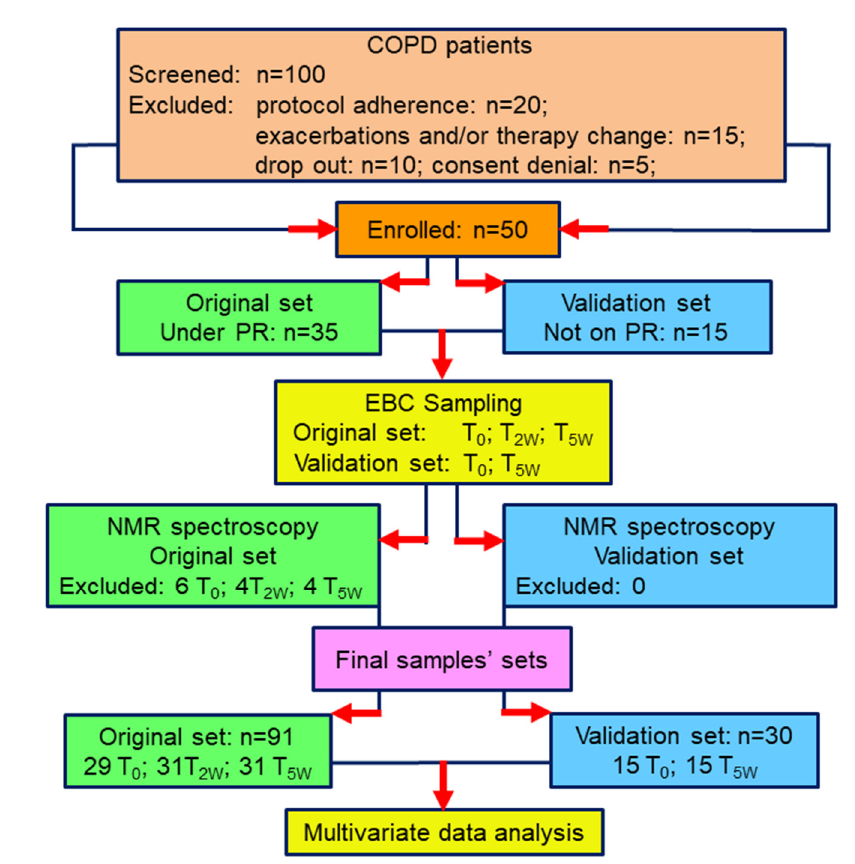
Figure 1. Schematic diagram illustrating the overall study design.